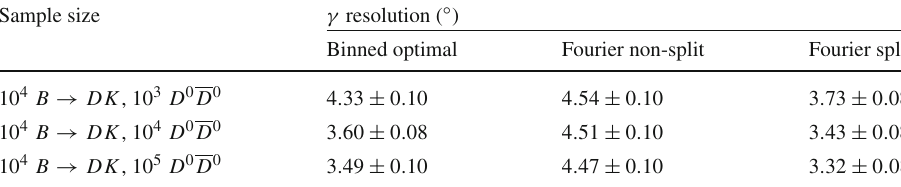
Sample size γ resolution ( ◦ )